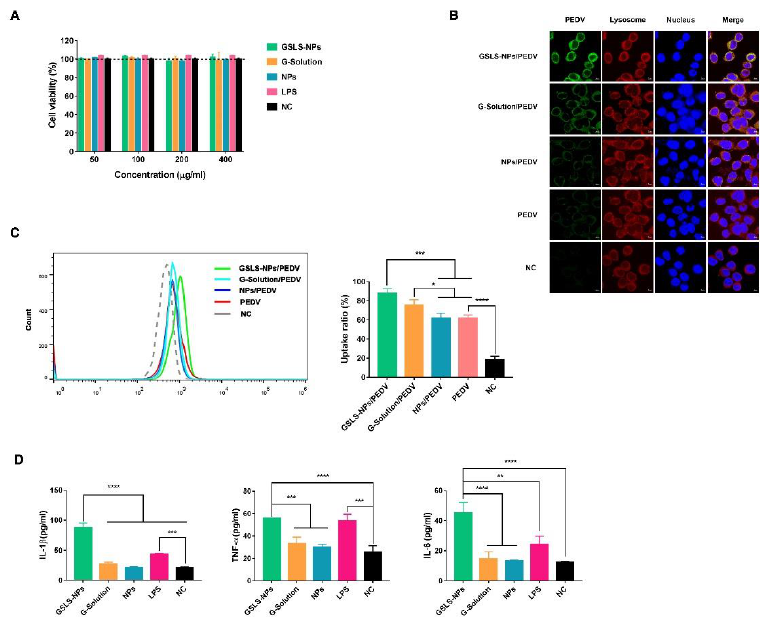
Figure 2. Effect of GSLS-NPs on the activation of DC2.4 cells. ( A ) Viability of DC2.4 cells measured with a CCK-8 assay after incubation with GSLS-NPs, G-Solution or empty NPs for 48 h. LPS was used as a positive control, and untreated cells served as a negative control (NC). ( B , C ) Representative fluorescence microscopy images and flow cytometric analysis of antigen uptake by DC2.4 cells after pre-treatment with GSLS-NPs, G-Solution, empty NPs or PBS for 4 h and incubation with the PEDV antigen for the following 24 h. ( D ) Production of cytokines by DC2.4 cells after 72 h of incubation. The experiments were performed in triplicate. Data represent the averages of triplicate samples from three identical experiments and are presented as the mean ± SD. Statistical analysis was performed using an unpaired Student’s t test. * p < 0.05, ** p < 0.01, *** p < 0 .001, **** p < 0.0001.